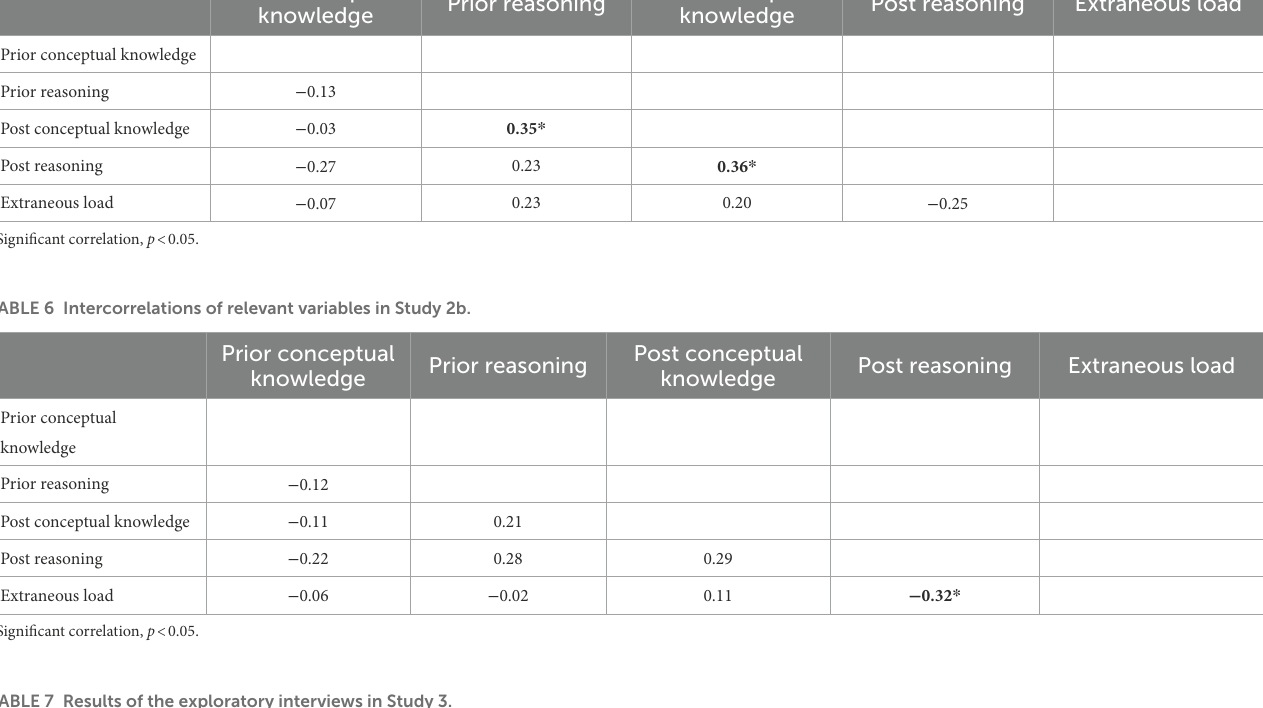
TABLE 7 Results of the exploratory interviews in Study 3.